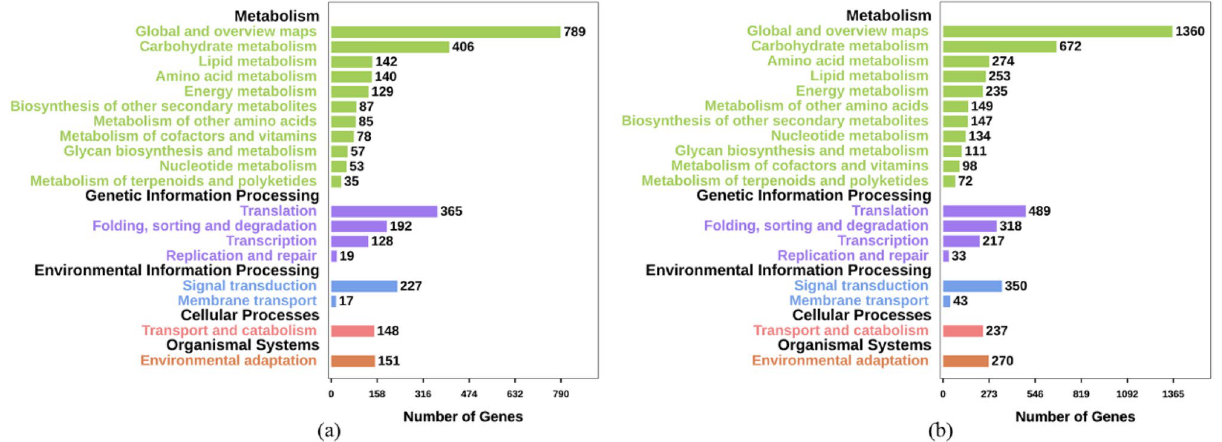
Figure 3. KEGG annotation of DEGs in the roots of walnut seedlings under nitrogen starvation ( a ) and excess ( b ). The ordinate represents the KEGG pathway, and the abscissa represents the number of